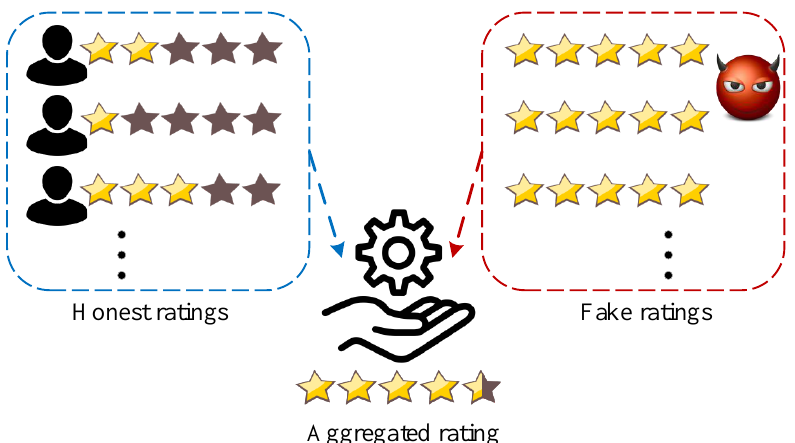
Figure 1. An example of sybil attack to rating